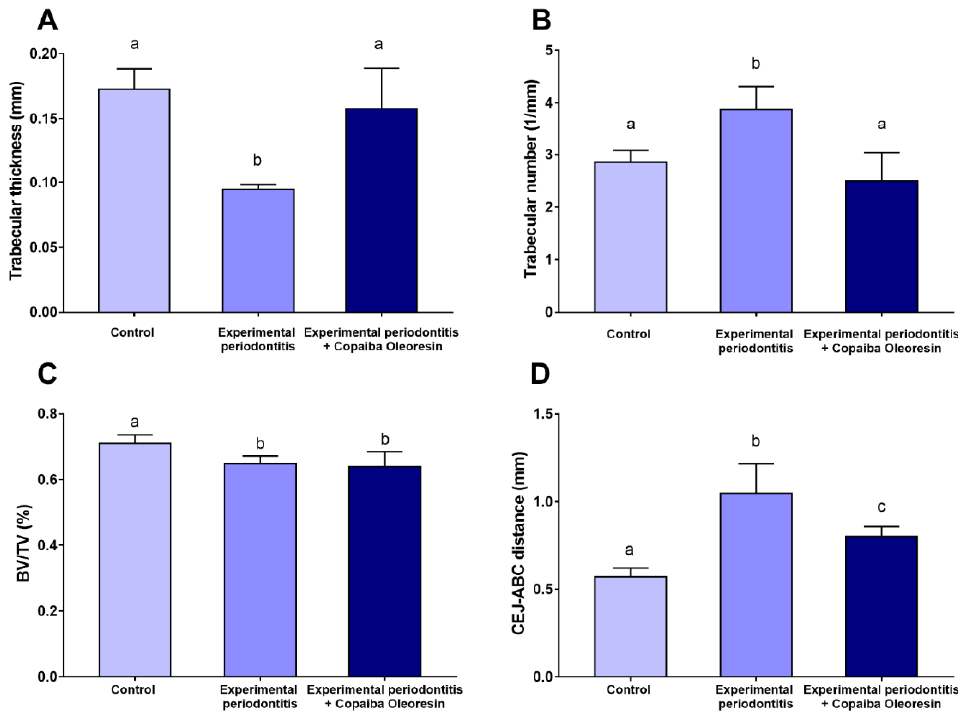
Figure 4. Microcomputed tomography results of the alveolar bone of rats with experimental perio- dontitis after copaiba oleoresin administration (200 mL/kg/day for 7 days). ( A ) Trabecular thickness (mm), ( B ) trabecular number (1/mm), ( C ) bone-to-tissue volume (BV/TV; %), ( D ) cementum – enamel junction to alveolar bone crest distance (CEJ-ABC; mm). Results are expressed as mean ± SEM. Dif- ferent letters indicate significant differences between the groups: one-way ANOVA with Tukey’s post hoc test ( p < 0.05).